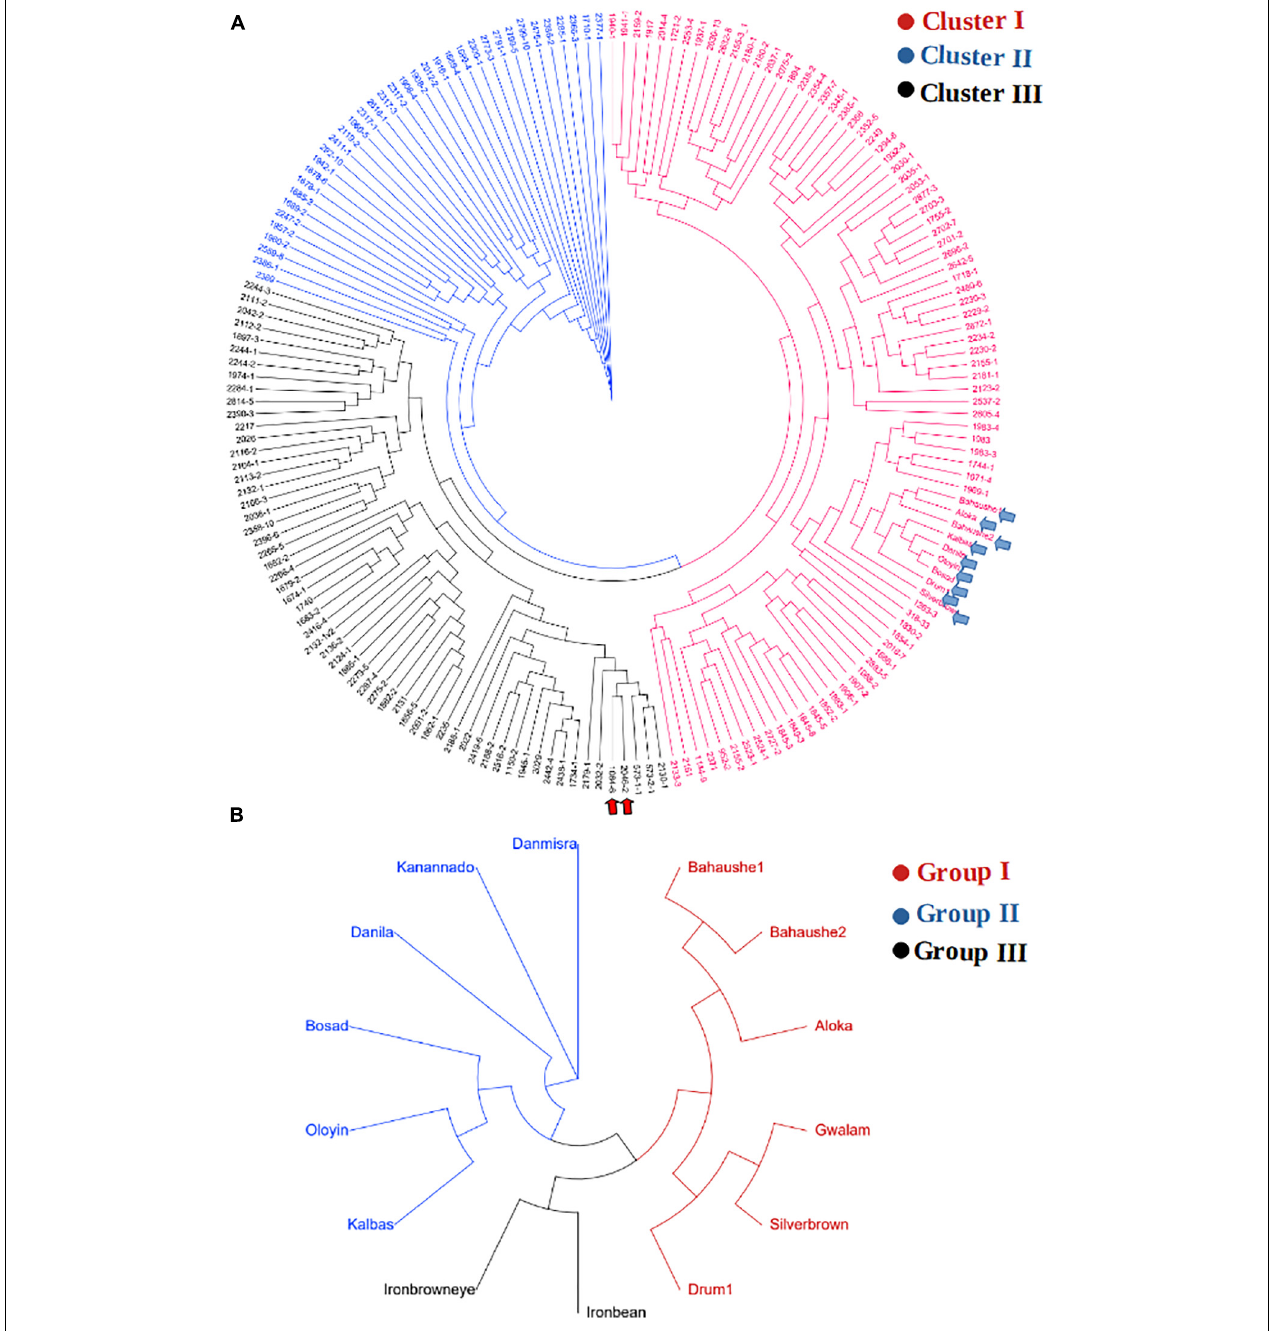
FIGURE 4 | Relationship among parents that were used to derive the F 1 progenies. (A) Cladogram showing grouping of parents into three clusters. The two elite varieties IT99K-573-1-1 and IT99K-573-2-1 were used as males and are emphasized in panel (A) by the red arrows, while cluster harboring the landraces are shown by the blue arrows. (B) Cladogram of landraces only, showing diversity among them despite being grouped together in Cluster I of panel (A) .